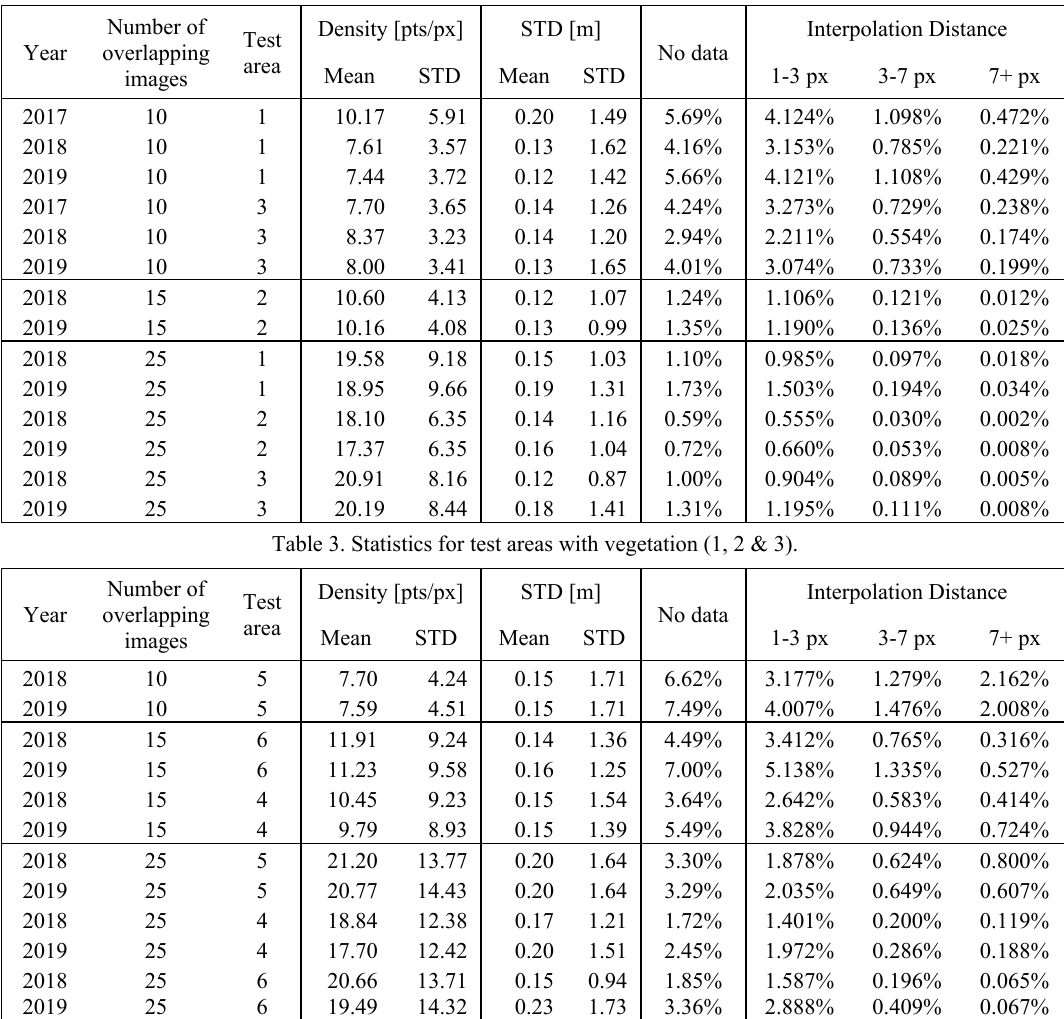
Table 4. Statistics for test areas covered with buildings (4, 5 &